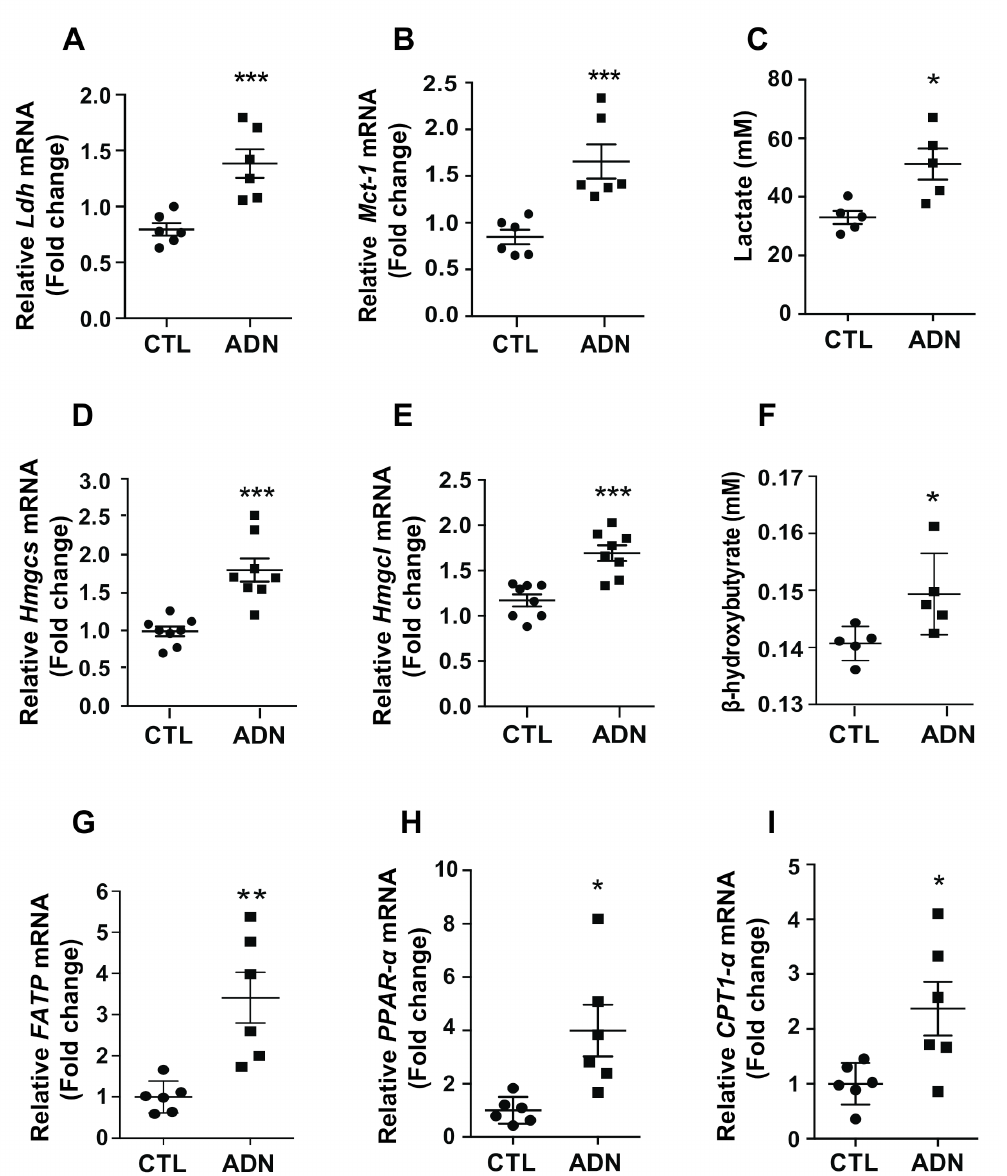
Figure 4. Adiponectin promotes production of lactate and ketone body in primary astrocytes. Primary astrocytes were seeded at 5 × 10 5 cell/well, starved overnight, and treated with adiponectin (1 µ g/mL) for 24 h. The elevated levels of mRNA encoding ( A ) lactate dehydrogenase (Ldh) and ( B ) monocarboxylate transporter-1 (Mct-1) genes were observed in adiponectin- treated primary astrocyte as determined by qRT-PCR ( n = 6 for each group). ( C ) The concentration of medium lactate was increased 24 h after adiponectin treatment ( n = 5 for each group). The elevated mRNA levels of ( D ) hydroxymethylglutaryl-CoA synthase (Hmgcs) and ( E ) hydroxymethylglutaryl-CoA lyase (Hmgcl) were observed in adiponectin-treated primary astrocytes as determined by qRT-PCR ( n = 8 for each group). ( F ) The medium concentration of β -hydroxybutyrate was increased 24 h after adiponectin treatment ( n = 5 for each group). The increased mRNA levels of ( G ) fatty acid transport protein (FATP) , ( H ) peroxisome proliferator-activated receptor- α (PPAR- α ) and ( I ) carnitine palmitoyltransferase 1- α ( CTP1- α ) were observed in the adiponectin-treated astrocytes compared with the that in vehicle-treated astrocytes ( n = 6 for each group). Results are presented as the means ± SEM. All experiments were performed from at least three different preparations of astrocytes. * p < 0.05; ** p < 0.01; *** p <